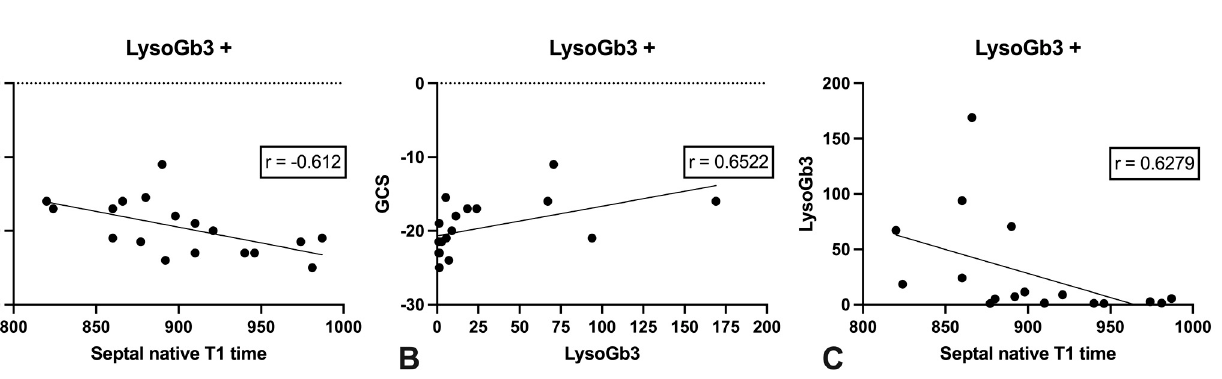
Figure 3. Correlations of LysoGb3 positive FD patients to GCS and septal native T1 time. Scatter plots showing the correlations of GCS and septal native T1 time ( A ), GCS and LysoGb3 ( B ), and septal native T1 time and LysoGb3 ( C ) in LysoGb3 positive (+) FD patients. Table 4. Cardiac function and morphology: FD Lyso-Gb3+ versus Lyso-Gb3-.